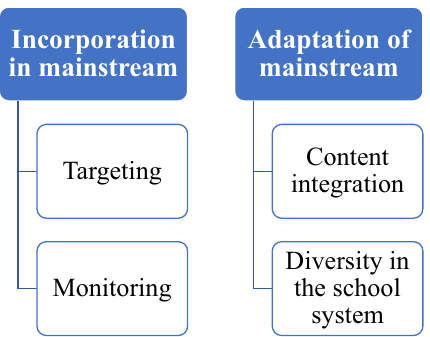
Fig. 1 Conceptual framework for assessing migration-related diversity mainstreaming in education